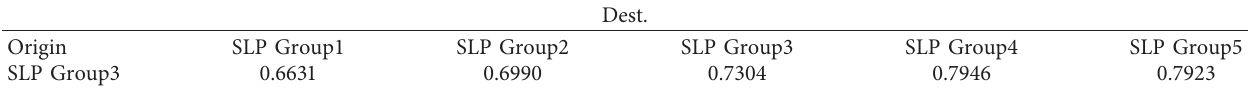
Table 3: The SLPSSI values for local windows from the origin (SLP Group3), Sunday versus Friday. Dest.